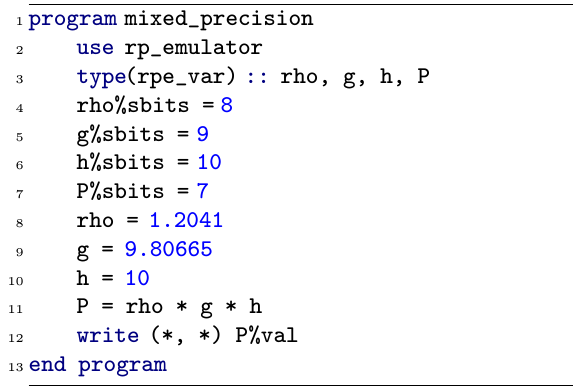
Figure 2. A simple numerical program utilizing emulated mixed- precision